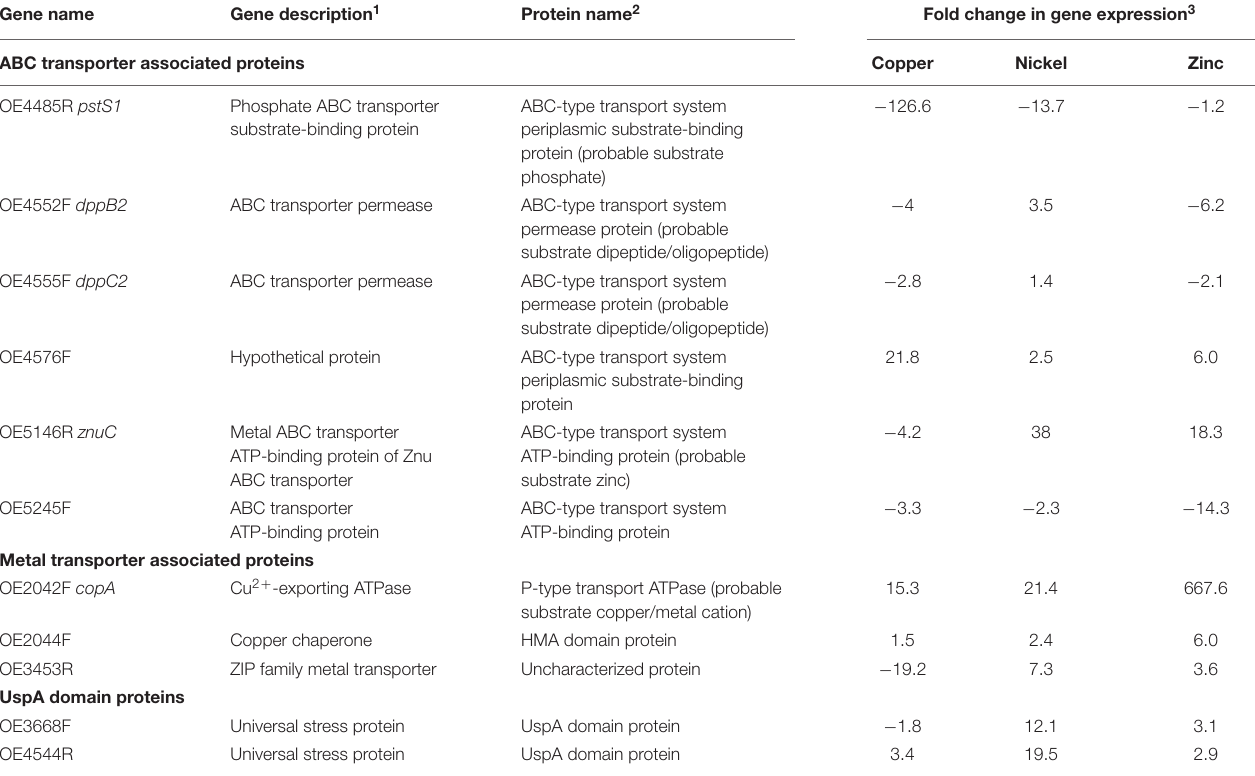
FIGURE 4 | Confocal laser scanning micrographs (CLSM) of H. salinarum biofilm structures after 24 h exposure to metal ions. Tilted top view (top) and side view (bottom) of biofilms grown for 12 days in complex medium and after different metal treatments for 24 h. Genomic DNA was stained with acridine orange (green), whereas eDNA and dead cells were stained with propidium iodide (red). Glycoconjugates ( α -mannopyranosyl and α -glucopyranosyl residues) were stained using Concanavalin A (ConA) Alexa Fluor R (cid:13) 647 (blue). Scale bars equal 25 µ m in each case. TABLE 3 | Target genes for gene expression studies in metal treated and untreated planktonic